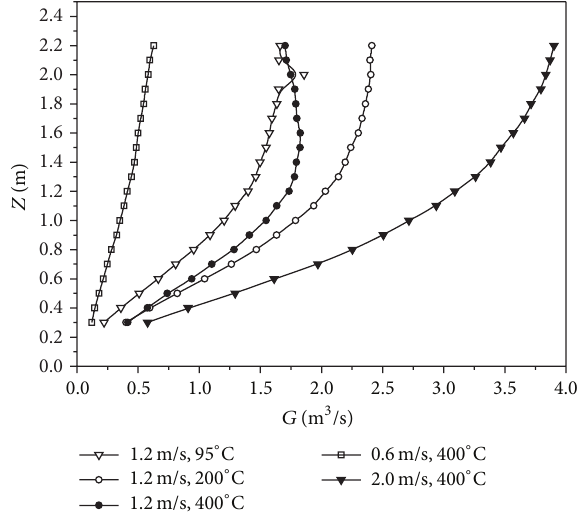
Figure 8: Volumetric flow rate of high-temperature annular buoy- ant jets at cross-section varying along with the height with different initial